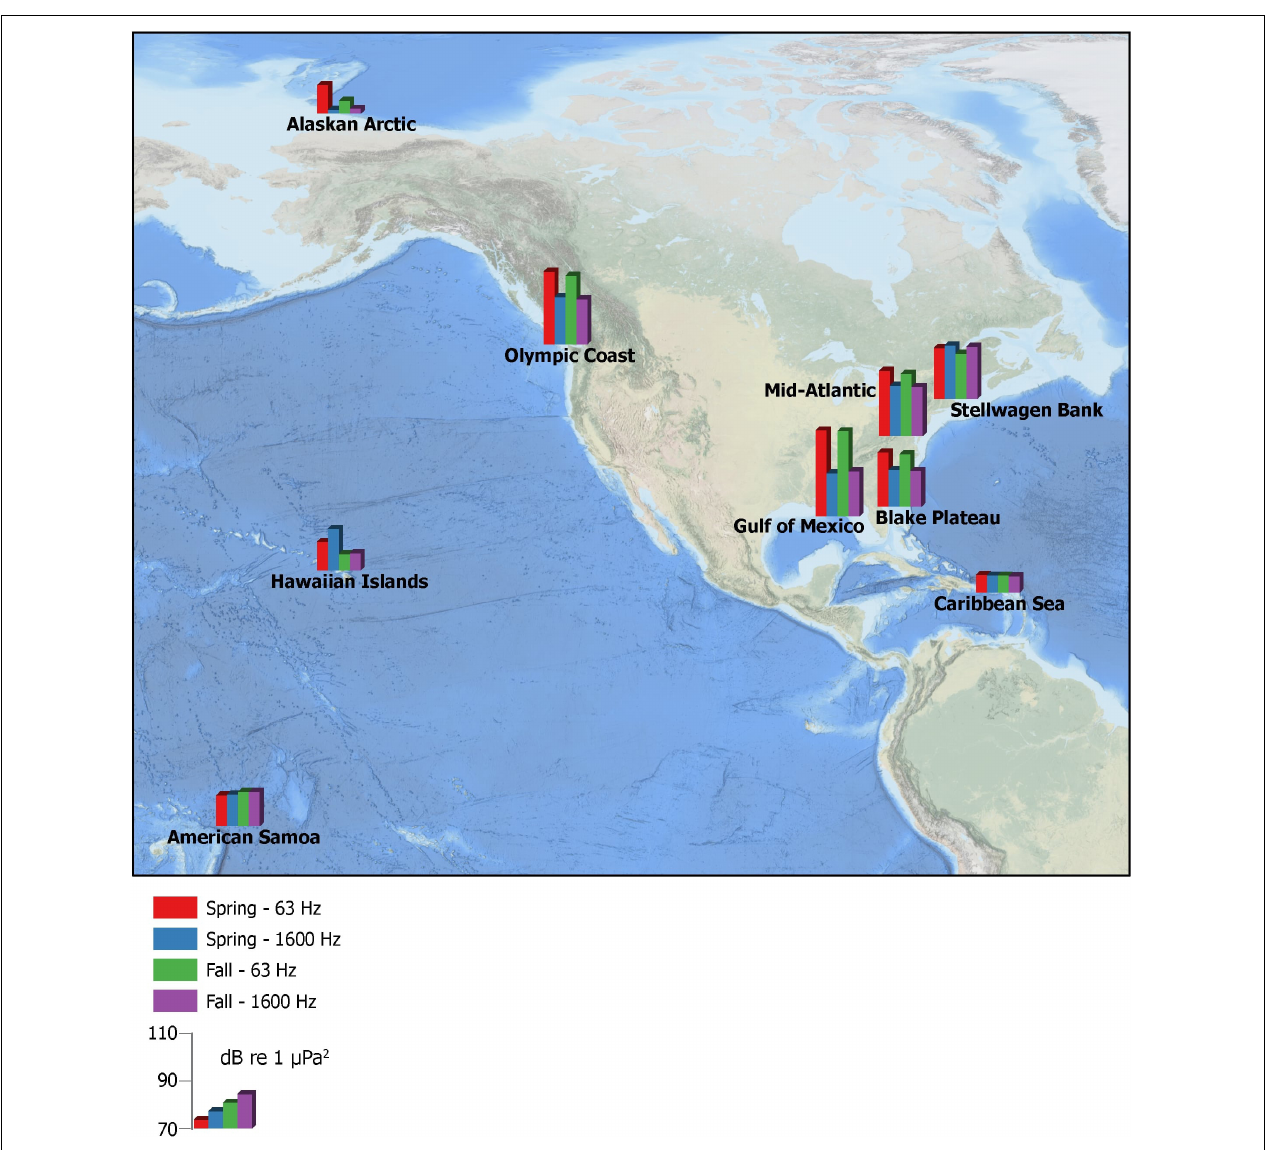
FIGURE 6 | Spatial distribution of the monthly median value for 63 and 1,600 Hz decidecade bands for spring (March) and fall (November) across the nine stationary recording sites. Bar height corresponds to SPL (dB re 1 µ Pa 2